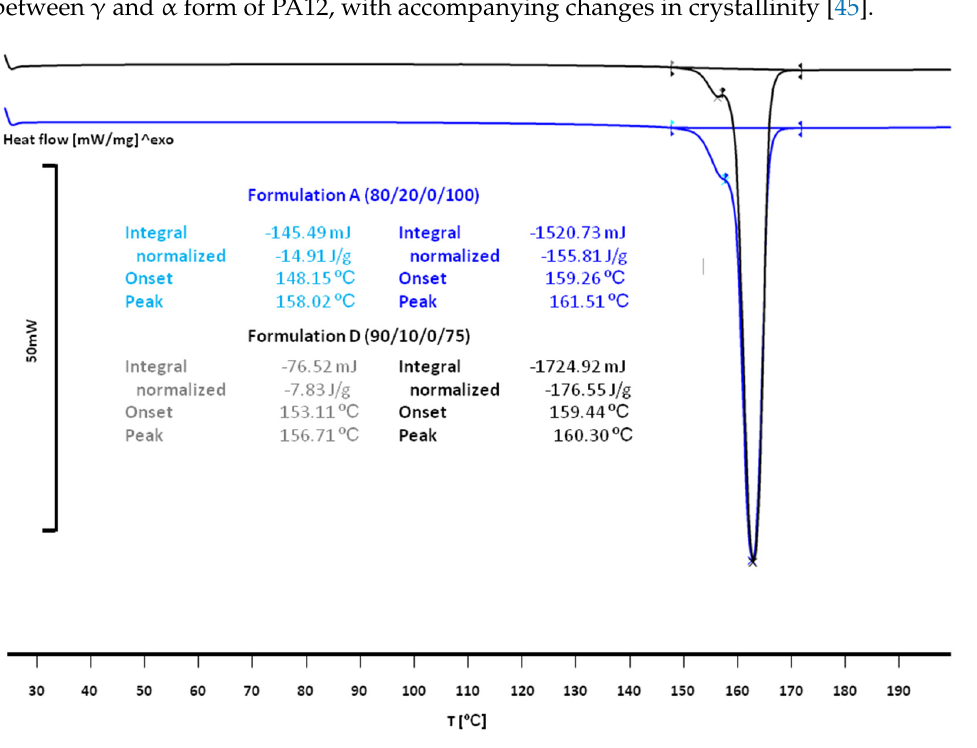
Figure 4. DSC curves of printlets from Formulation A (80/20/0/100) and Formulation D (90/10/0/75). DSC thermograms of Met/PA12 mixtures confirmed the presence of Met. An addi- tional, small endothermic effect was observed in DSC curves of printlets apart from the pure Met melting effect. It was supposed that this small effect originated from poly- morphic transitions of PA12.